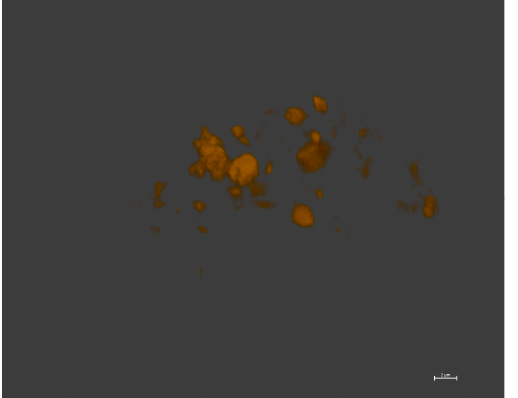
Figure 7. TEM images of drug-loaded (10 wt.% Dox · HCl) polymersomes stained with 1.0 wt.% phosphotungstic acid solution (scale bar = left 1 µ m, right 0.2 µ m).